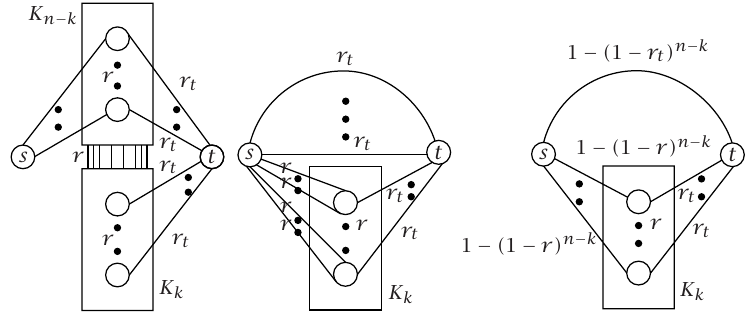
(n,q s ,q t ,q) when n − k edges between s and intermediate Figure 5.2 . G (cid:5) A nodes work and the rest